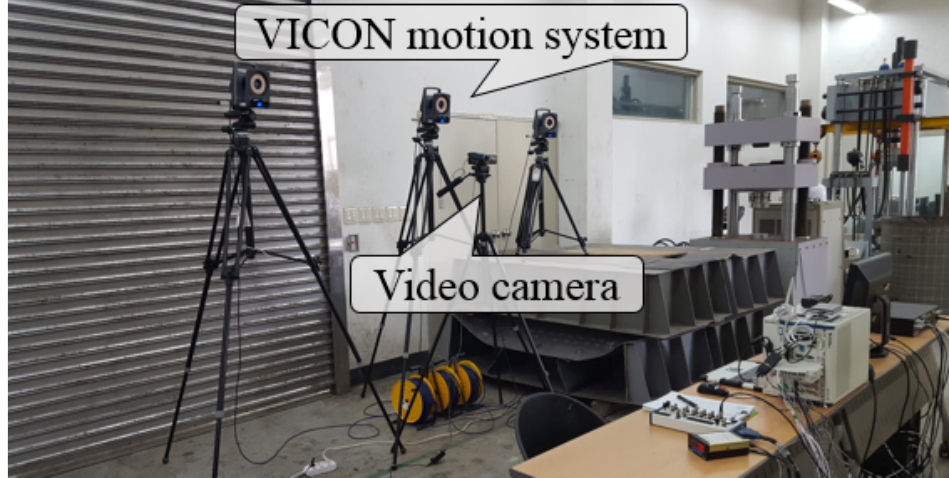
Figure 11. The VICON motion system measuring the lateral deflections of the model.